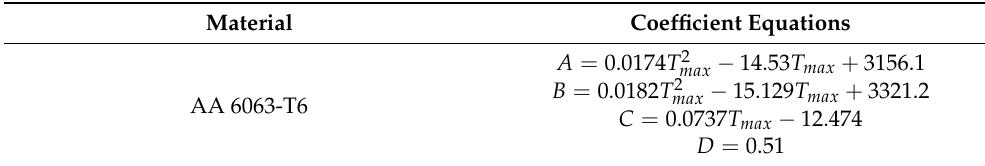
Table 4. Equations of Hocket–Sherby coefficients as a function of maximum temperatures for AA6063-T6.